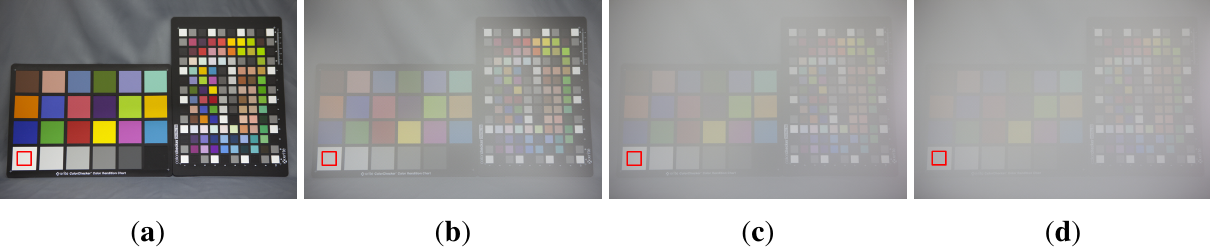
Figure 1. Test images acquired from the same indoor scene with a different amount of steam generated by a humidifier: ( a ) the haze-free image without steam; and ( b – d ) the hazy images with different amounts of steam.